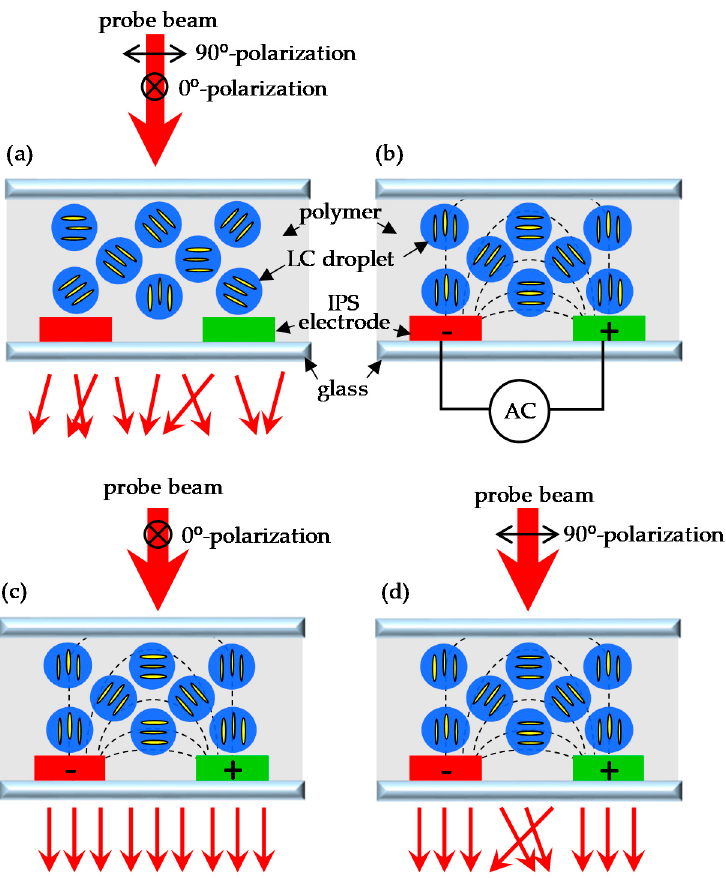
Figure 3. A schematic diagram and the operating principles of the PDLC grating ( a ) without voltage; ( b ) with voltage; ( c ) with probe beam of 0 ° polarization; ( d ) with probe beam of 90° polarization. The black dashed line represents the electric field.